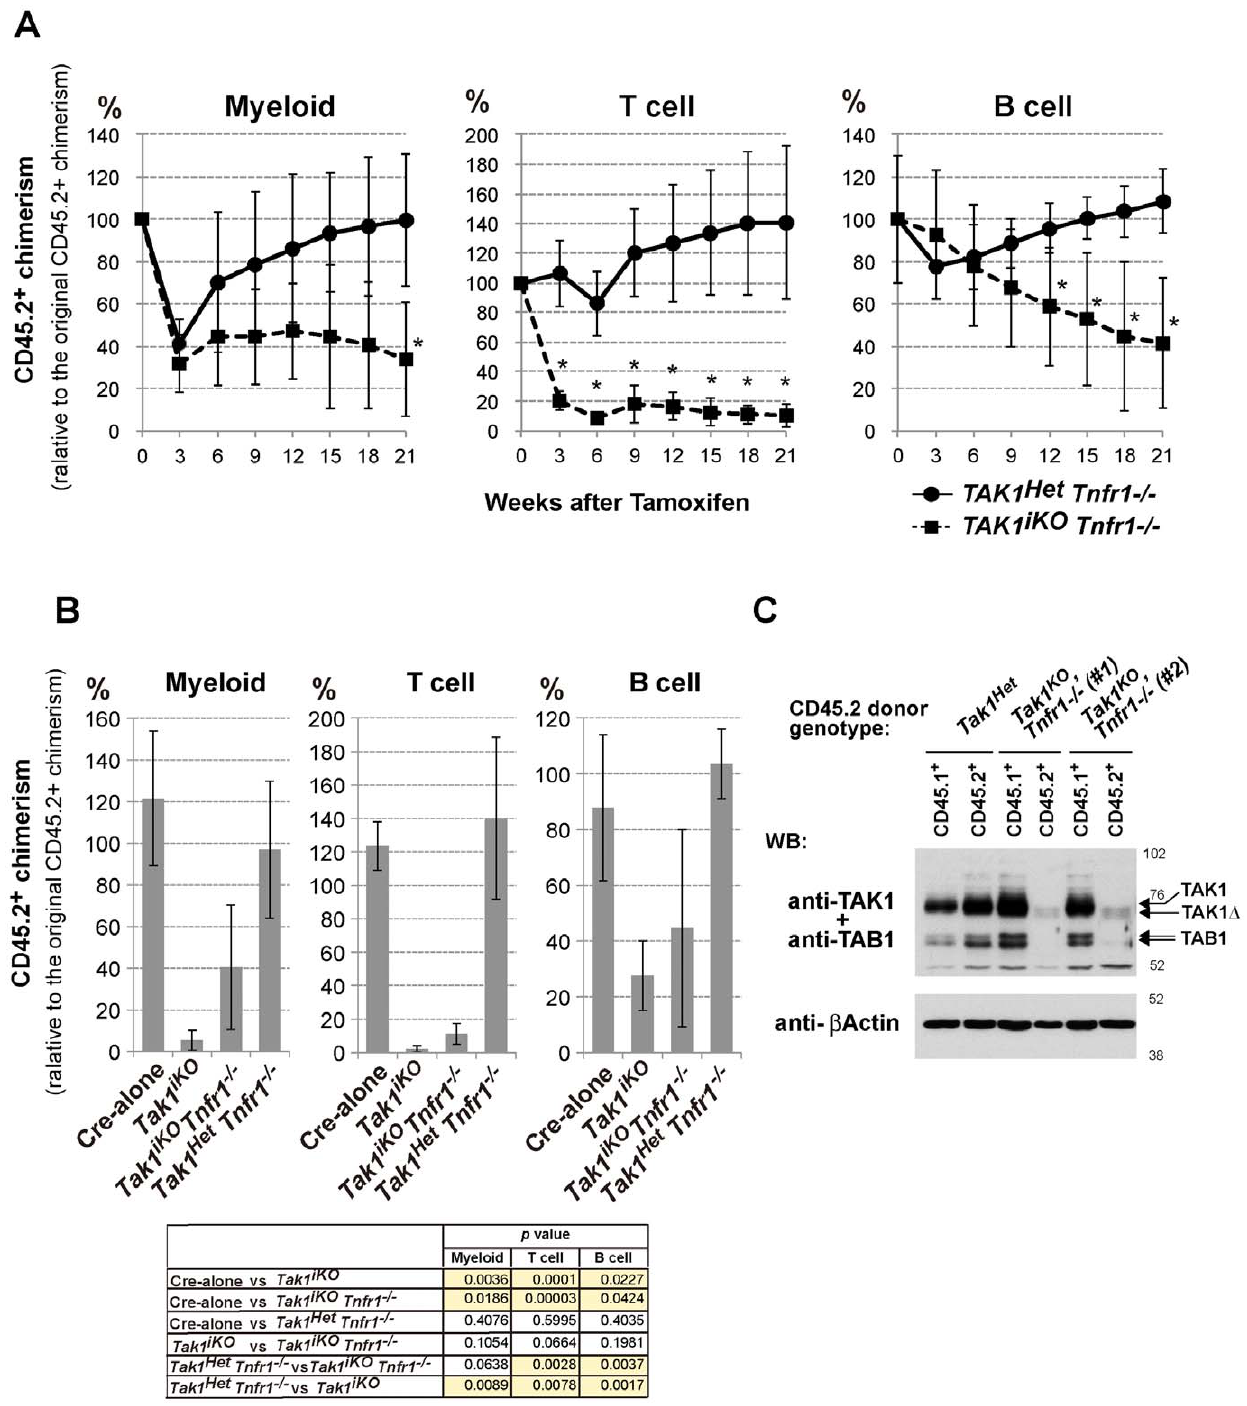
Figure 5. Ablation of TNF signaling partially restores the reconstitution potential of Tak1 -deficient HSCs. (A) Competitive reconstitution assay. 2 6 10 5 BMN cells from control Tak1 Het Tnfr1 2 / 2 (n=3) or Tak1 iKO Tnfr1 2 / 2 mice (n=4) (CD45.2 + ) were transplanted into lethally irradiated recipients (CD45.1 + ) together with 2 6 10 5 competitor wild type BMN cells (CD45.1 + ). At six weeks post transplantation (designated as Week 0), the chimerism of myeloid, T and B cells in the recipients’ PB was analyzed, and then the recipients were i.p. injected with tamoxifen at 160 mg/kg body weight for three consecutive days. The chimerism of PB cells was monitored every three weeks, and is shown as the mean 6 S.D. (*p , 0.05) (B) Competitive reconstitution assay of Cre-alone (n=3) and Tak1 iKO (n=3) was also performed as described above, and compared with Tak1 Het Tnfr1 2 / 2 (n=3) and Tak1 iKO Tnfr1 2 / 2 (n=4) at 18 weeks post-tamoxifen injection. The table shown below the graphs indicates statistical significance for the indicated comparisons. P values of less than 0.05 are highlighted. (C) Expression of TAK1 and TAB1 proteins in the donor-derived splenocytes. Whole spleen cells from control Tak1 Het and two independent Tak1 iKO Tnfr1 2 / 2 transplanted mice ( # 1 and # 2) at 15 weeks post-tamoxifen injection were sorted into the CD45.1 + or CD45.2 + population. Total cell lysates from the sorted splenocytes from control Tak1 Het , and Tak1 iKO Tnfr1 2 / 2 # 1 and # 2 were analyzed by SDS-PAGE and Western blotted with anti-TAK1, TAB1 or anti- b -actin antibodies. The positions of molecular weight markers are shown on the right. The arrows indicate the bands corresponding to endogenous TAK1 and TAB1, and truncated TAK1 (TAK1 D ) resulting from Cre-mediated recombination. doi:10.1371/journal.pone.0051073.g005 PLOS ONE |